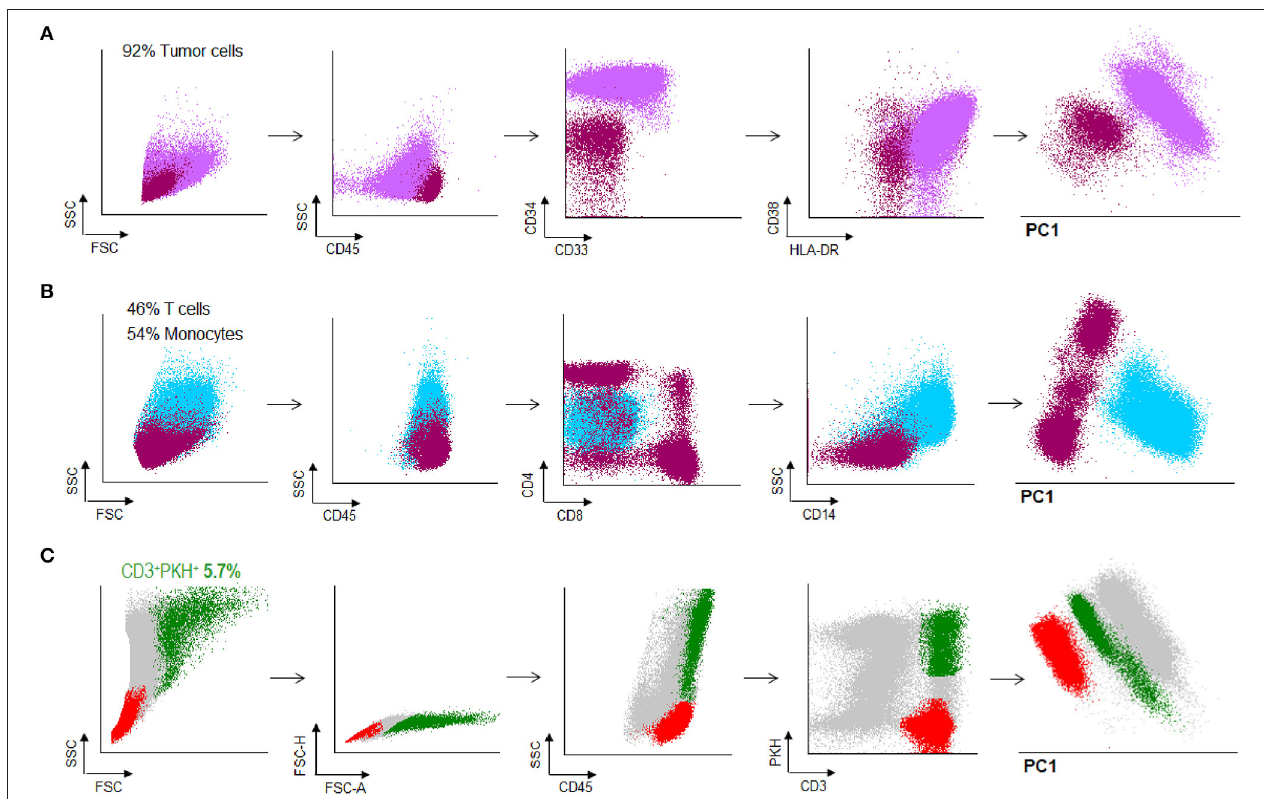
FIGURE 5 | Doublet-forming T cells from peripheral blood of AML patients . (A) Blast cells from bone marrow of an AML patient were obtained and frozen. The immunophenotype of AML cells was: CD45low CD34 ++ , CD38 + , HLA-DR + (purple population). (B) PBMC were obtained from peripheral blood when the patient was in CR and analyzed by flow cytometry. T cells represented the 46% of the total PMBC. (dark pink population) (C) T cells from the patient were co-incubated with AML cells. Doublet-forming T cells were identified based on their FSC/SSC characteristics, doublet zone FSC-A/FSC-H as well as their positivity for CD45 and both PKH and CD3 (CD3 + PKH + ; green population). Non-doublet T cells were also isolated to use them as control (CD3 + PKH–; red population); one representative case is